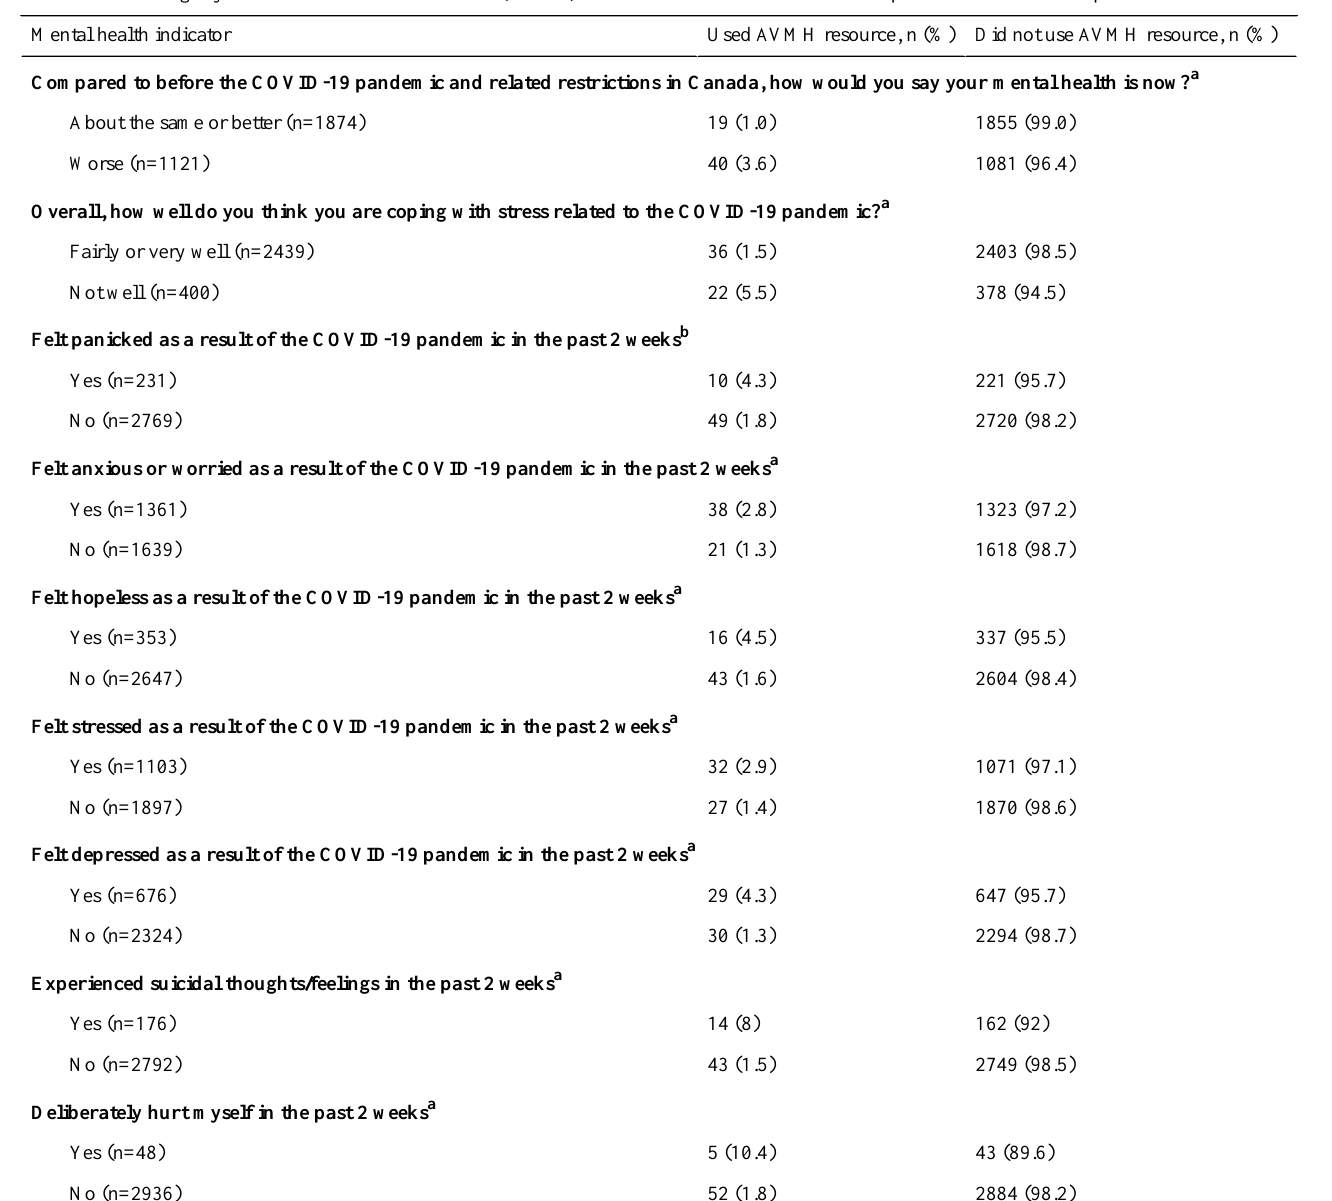
Table 2. Accessing asynchronous virtual mental health (AVMH) resources across indicators of self-reported mental health impact.